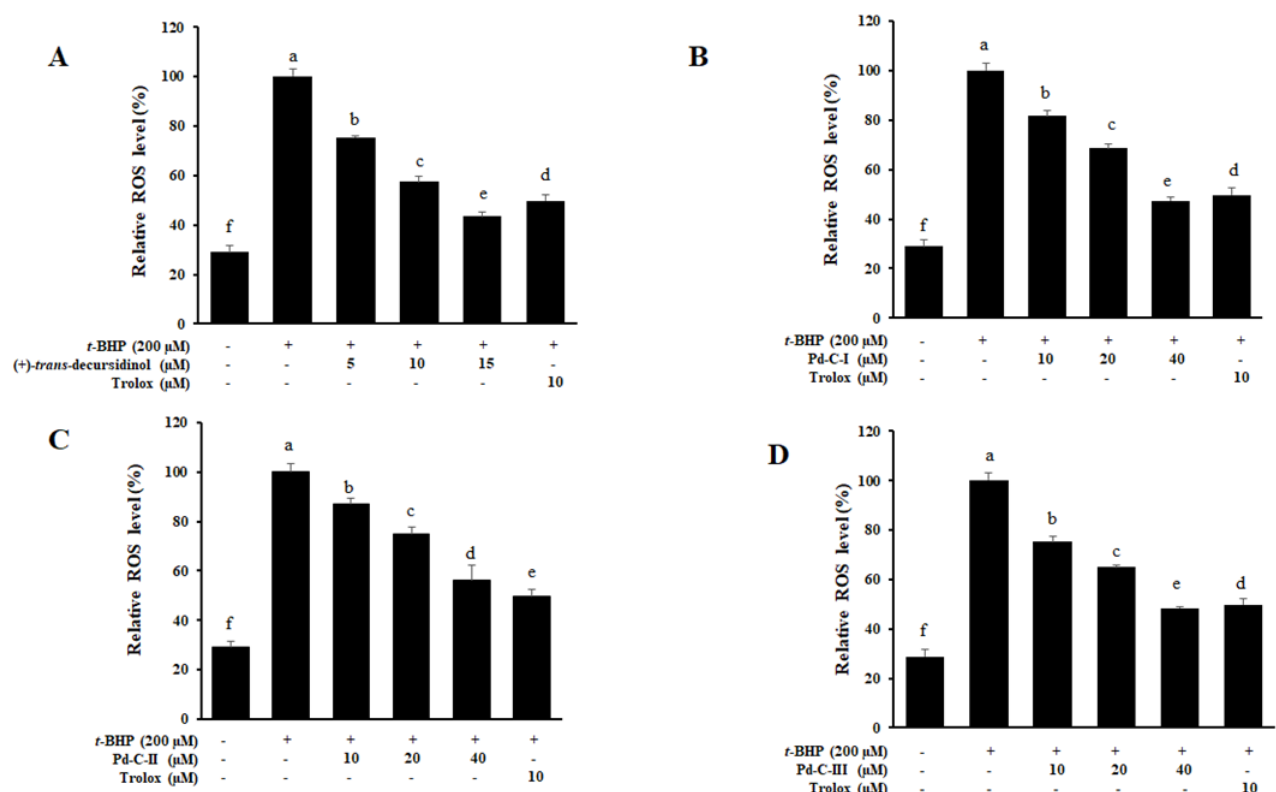
Figure 7. Effects of (+)- trans -decursidinol ( A ), Pd-C-I ( B ), Pd-C-II ( C ), and Pd-C-III ( D ) on tert -butyl hydroperoxide ( t - BHP)-induced reactive oxygen species (ROS) generation in HepG2 cells. Dihydroxanthyletin-type coumarins and trolox (10 µ M) cells pretreated at var ying concentrations (5 to 40 µ M), for 1 h have been stimulated for 30 min with 200 µ M t -BHP. ROS levels were measured by 2 (cid:48) ,7 (cid:48) -dichlorodihydro fluoresce in diacetate with fluorescent analysis. The control values were obtained in the absence of t -BHP (200 µ M), coumarins after the addition of t -BHP (200 µ M). As a positive control, trolox was used. Data are expressed as the mean ± SEMs of three independent experiments. a–f Mean with different letters are significantly different with Duncan’s test at p < 0.05. f Indicates the unstimulated control group, a Indicates t -BHP-treated group. Table 4. Inhibitory effects of dihydroxanthyletin-type coumarins on ONOO − and